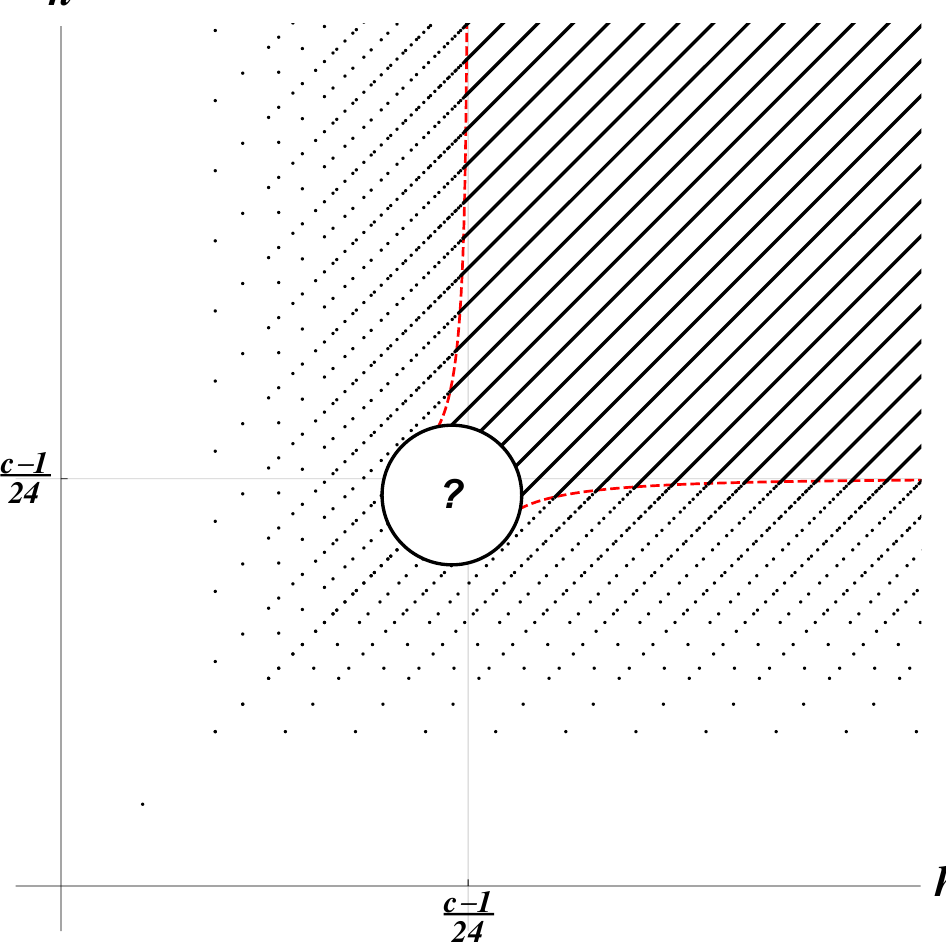
Figure 1 . A conjectural cartoon of the spectrum of primaries of an irrational CFT. This paper addresses two features of the spectrum, namely multi-twist operators and the extremality bound, and their relation through modular invariance. The points represent composite multi-twist opera- tors, which grow polynomially in number at large spin. The region above the red dashed line | the extremality bound | represents the ‘continuum’ of operators, with entropy growing as large spin ‘ or central charge c . The twist of light operators determines the shape of the extremal- ity bound. Generically, we can only trust this picture in an asymptotic expansion in spin, so the region ? (cid:13) without perturbative control is large. In a theory with weakly coupled AdS 3 dual, the perturbation theory is instead controlled by large central charge, the validity is extended, and ? (cid:13) is small compared to c